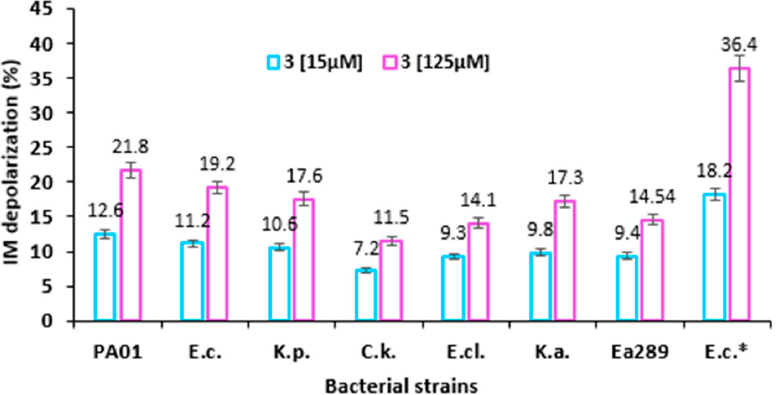
Figure 3. Inner membrane depolarization of various Gram-negative bacteria (PA01, E. coli ATCC 25922, K. pneumoniae ATCC 13883, C. koseri IP8294, E. cloacae DSM 129, K. aerogenes ATCC 13048, K. aerogenes 289 (MDR), and E. coli AG100A_pUC18) by evaluating DiSC 3 (5) fluorescence recorded af ‐ ter 5 minutes in the presence of compound 3 at 15 μ M and 125 μ M. * Refers to E. coli